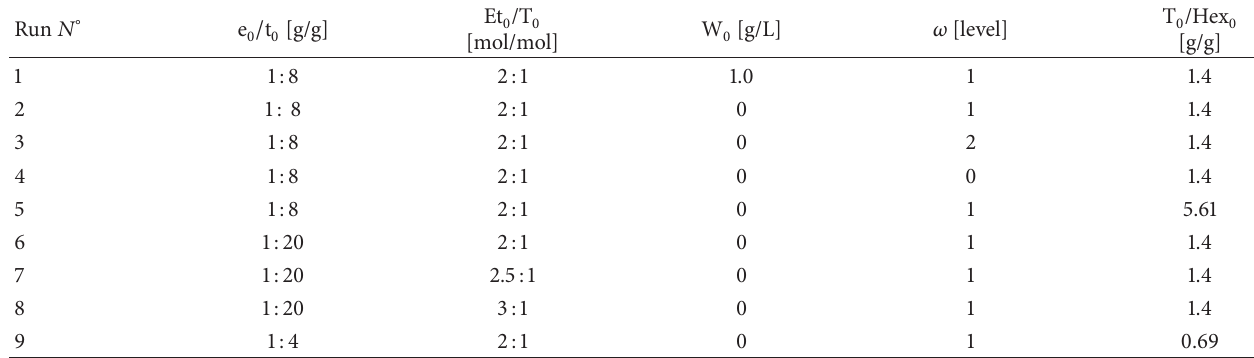
Table 1: Experimental conditions exploited to perform the enzymatic transesterification reactions.